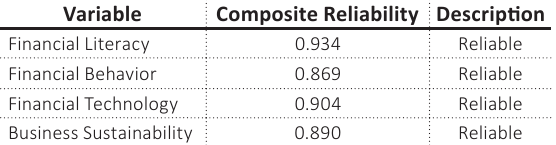
Tables 3. Reliability